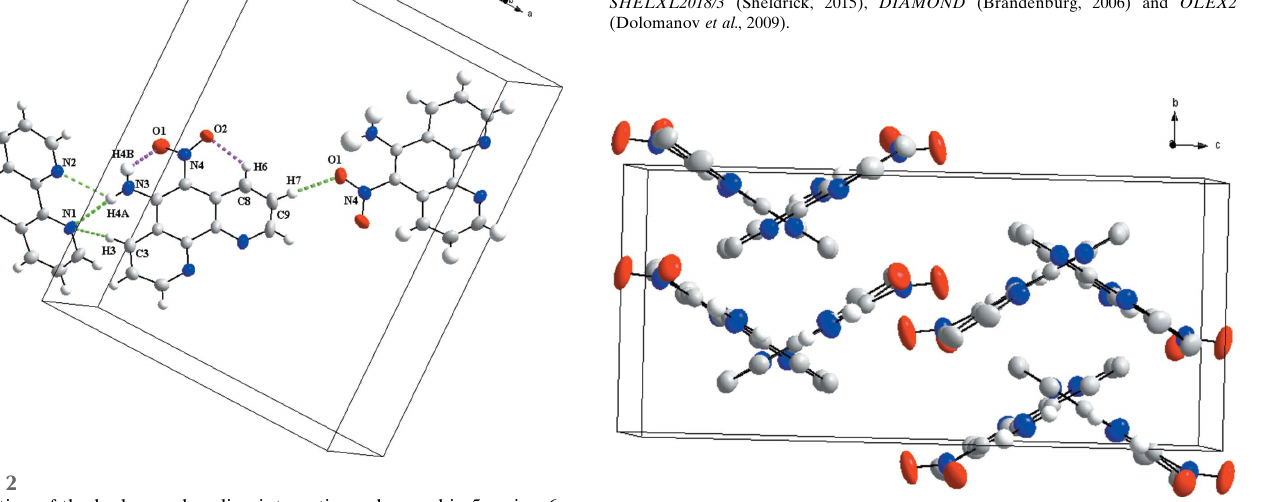
Figure 3 Representation of the packing of 5-amino-6-nitro-1,10-phenanthroline along the a axis.